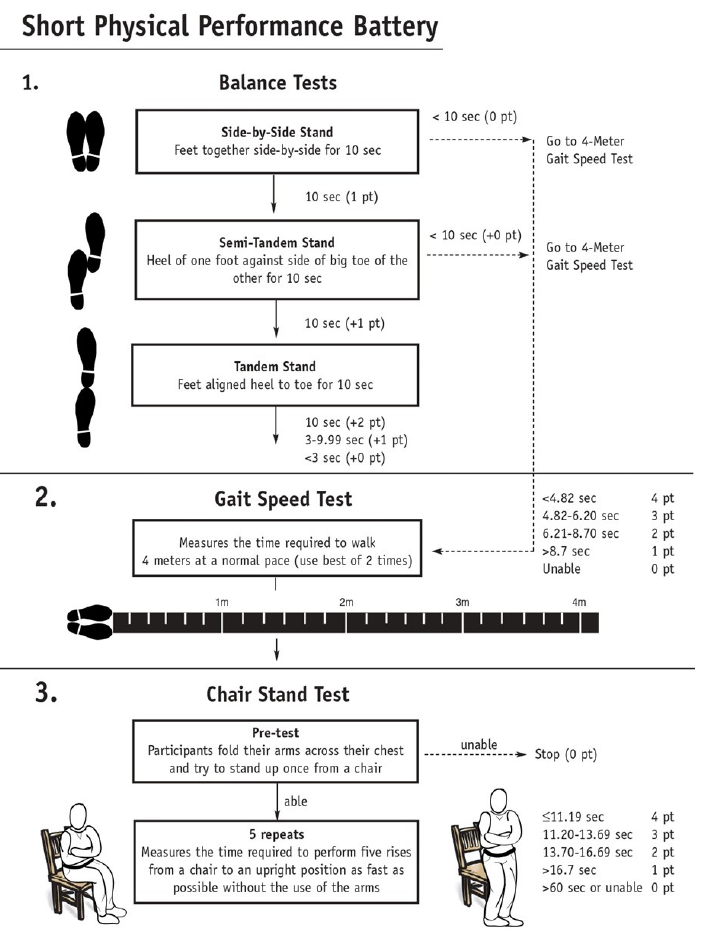
Figure 1. Short physical performance battery—SPPPB. Source: Wall chart courtesy of Dr. Jack Guralnik.